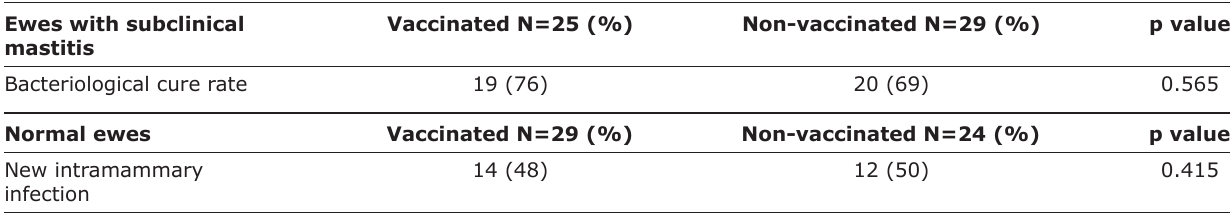
Table-1: Bacteriological cure rates in vaccinated and non-vaccinated ewes with subclinical mastitis and new intramammary infection rates in normal ewes following vaccination using a commercially available polyvalent mastitis vaccine.